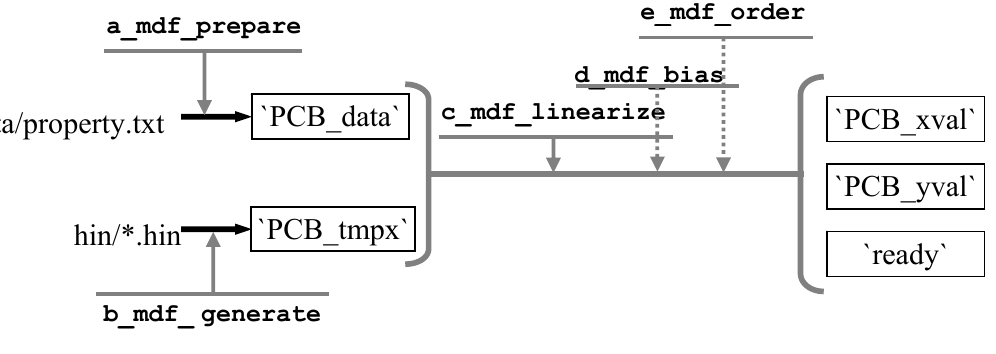
Figure 2. Preparing data for Multiple Linear Regression analysis.